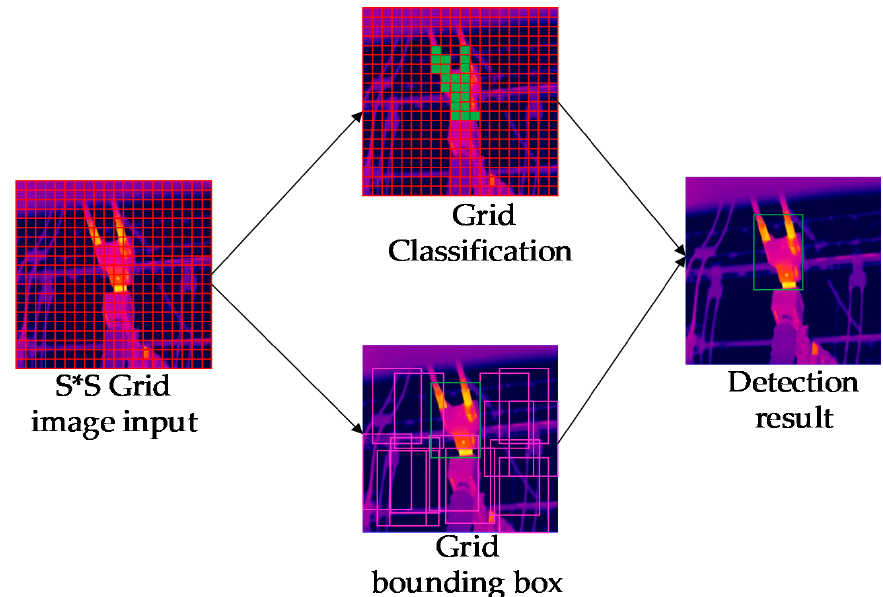
Figure 1. Detection process.